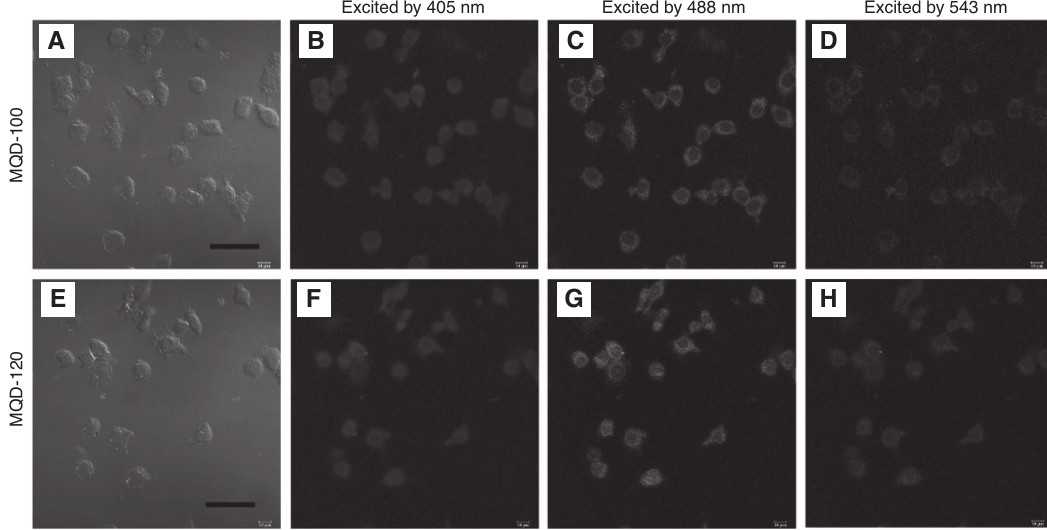
Figure 7: Bright-field imaging of RAW264.7 cells and the confocal imaging of the cells incubated in MQD-100 and MQD-120. (A and E) Bright-field imaging of RAW264.7 cells. Confocal imaging (405, 488, and 543 nm) of RAW264.7 cells incubated with (B–D) MQD-100 and (F–H) MQD-120. Adapted with permission from [87], Wiley-VCH Verlag GmbH & Co. KGaA,